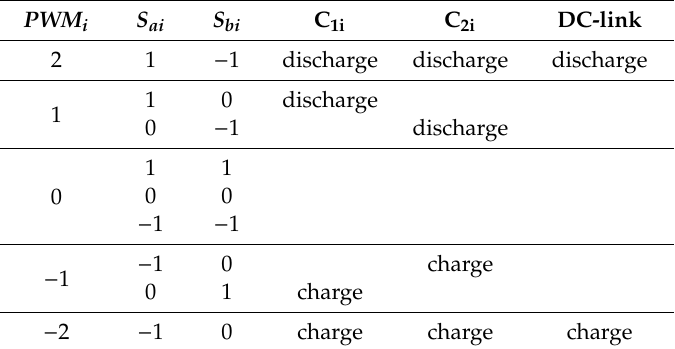
Table 1. Characteristics of module levels